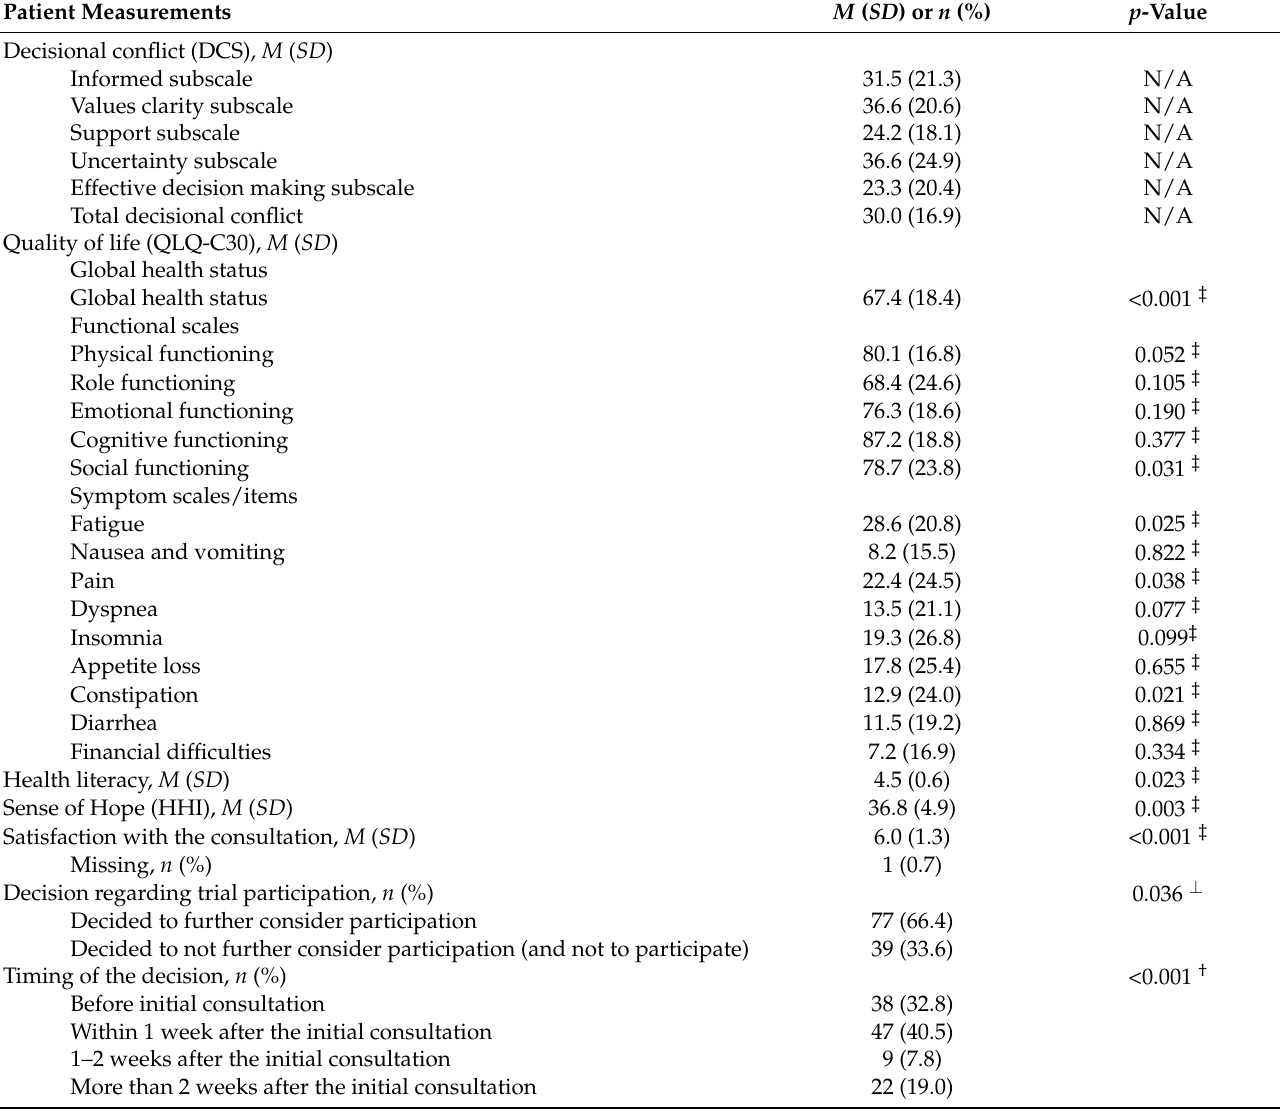
Table 3. Patient measurements ( n = 116). p -values are provided for the univariate relation with decisional conflict.